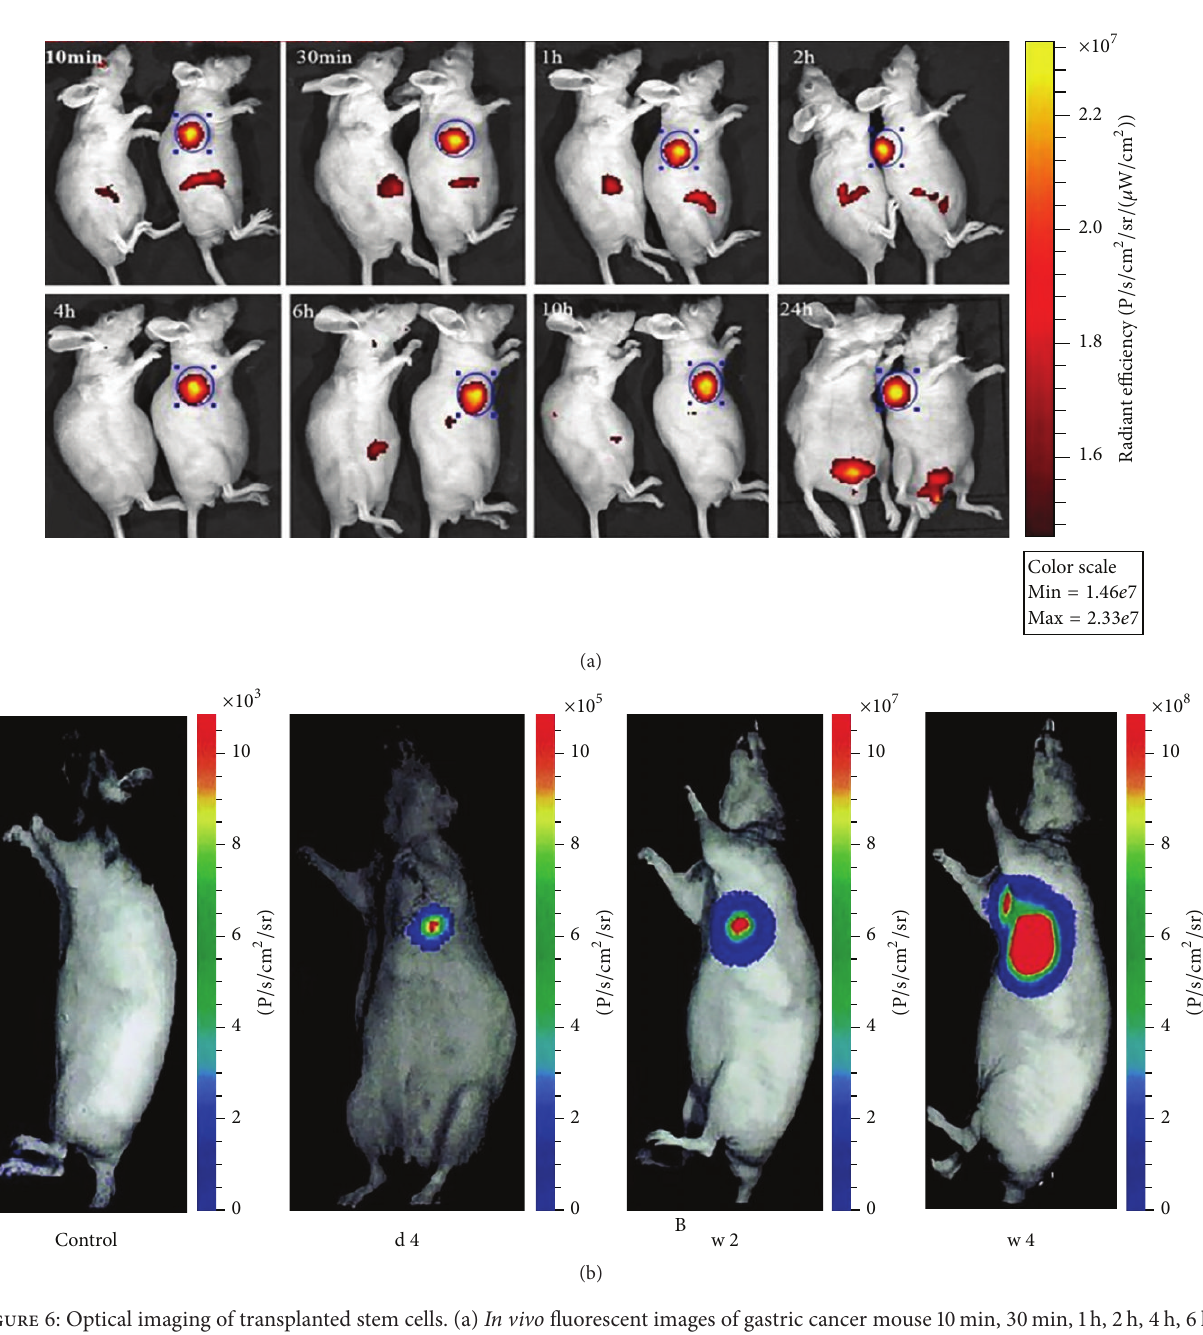
Figure 6: Optical imaging of transplanted stem cells. (a) In vivo fluorescent images of gastric cancer mouse 10min, 30 min, 1h, 2 h, 4 h, 6 h, 10h, and 24 h after injection of DiR labeled murine ESCs. Reproduced courtesy of the Ivyspring International Publisher Group [104]. (b) Bioluminescent image of implanted ESCs in weeks 1, 2, and 4. (b) shows that the luciferase reporter gene is capable of performing long-term tracking in the migration and viability of implanted cells, which in this case form a teratoma. Reproduced courtesy of Wolters Kluwer Health, Inc.